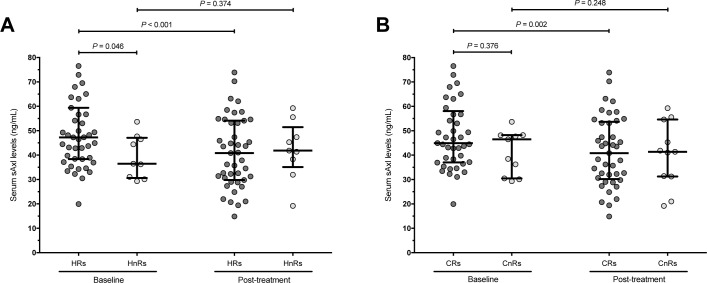
sAxl levels in relation to treatment outcomes.The scatterplots illustrate differences in soluble (s)Axl levels in patient groups stratified based on histological (A) and clinical (B) outcomes. Baseline serum sAxl levels were higher in histological responders (HRs) compared to histological non-responders (HnRs) (P-value derived from Mann-Whitney U test), and decreased following treatment in HRs but not in HnRs (P-values derived from Wilcoxon signed-rank tests). Accordingly, sAxl levels decreased following treatment in clinical responders (CRs) but not in clinical non-responders (CnRs). Lines and whiskers denote medians and the 25th and 75th percentiles. Outliers may have been omitted due to scaling.